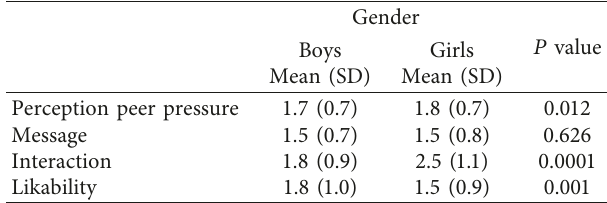
Table 3: Correlation of gender with perception of peer pressure ( N � 738).